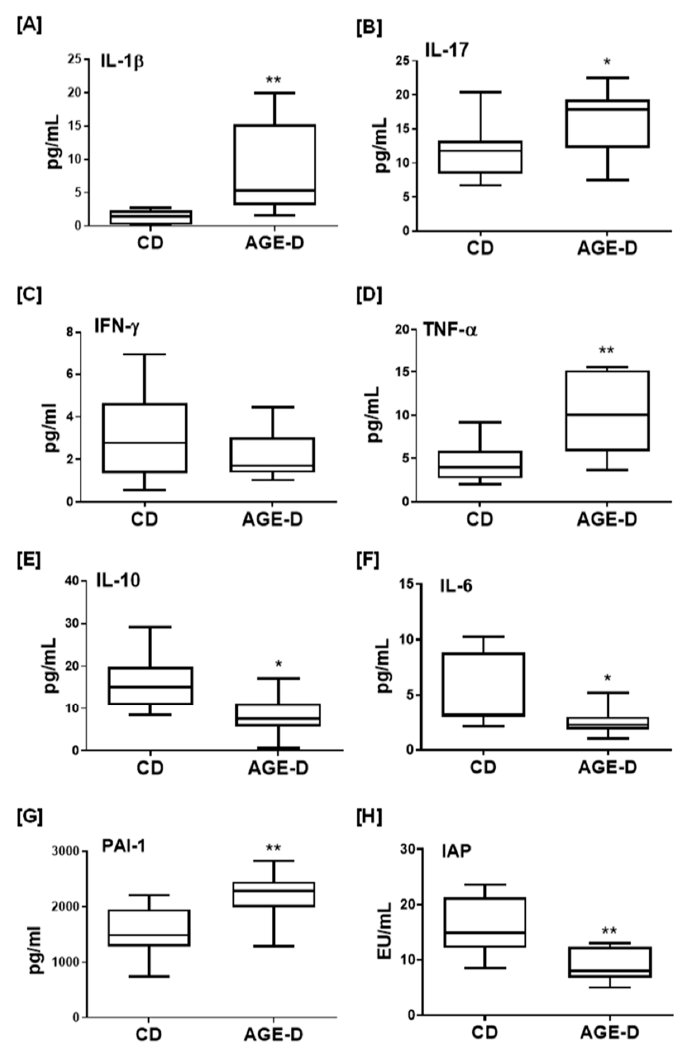
Figure 5. ( A – G ) Systemic inflammation markers evaluated in plasma of CD and AGE-D mice by multiplexed Bio-Plex 3D system, indicating increased pro-inflammatory (IL-1 β , IL-17, IFN- γ , TNF- α , and PAI-1) and decreased IL-6 and IL-10. ( H ) Activity of intestinal alkaline phosphatase (IAP) evaluated in plasma by kinetic assay, indicating reduced ability of AGE-D mice to maintain microbiota homeostasis and loss of detoxifying potential in intestine. Data are means ± S.E.M. ( n = 15 per group). Statistical significance: * P < 0.05, ** P < 0.01 vs. CD.